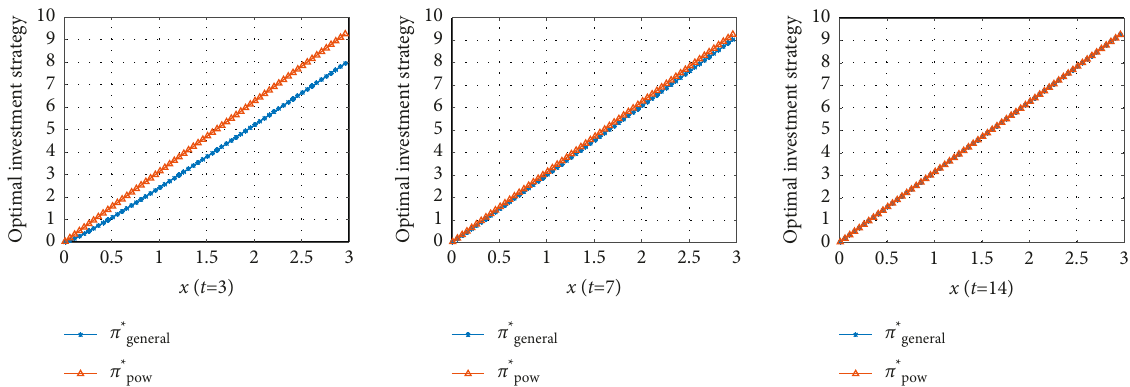
Figure 3: Impacts of ( x ) on optimal investment strategies with different values of ( t